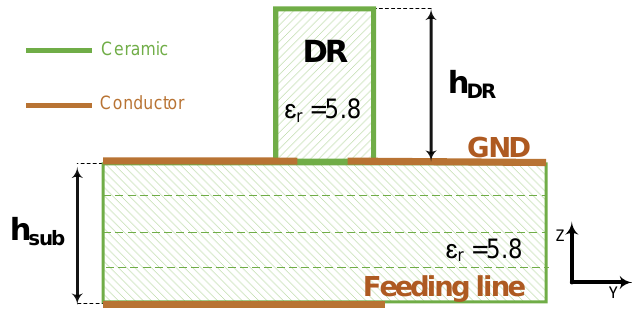
Figure 1. The schematic stack for single element CDRA.